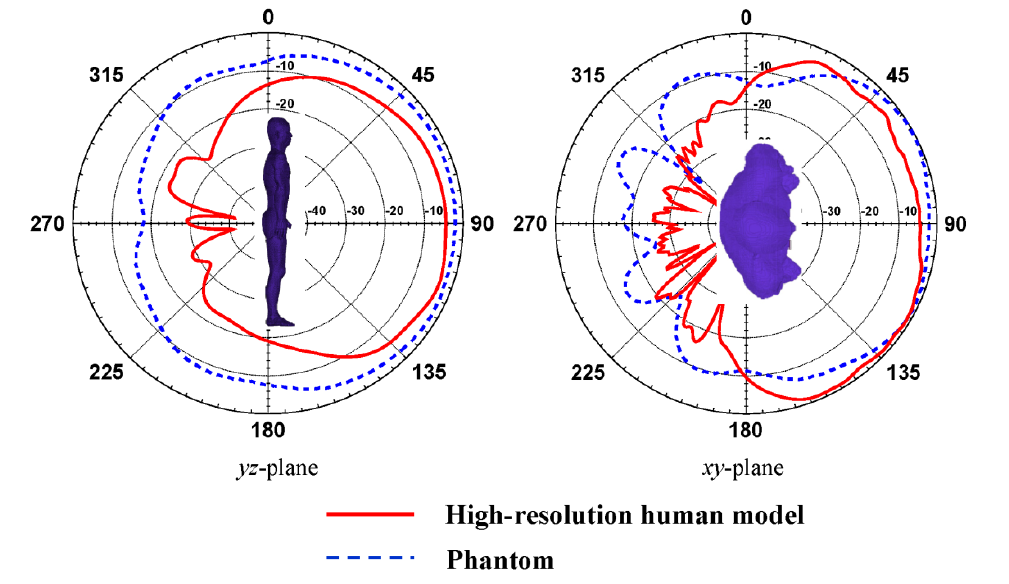
Figure 13. Simulated radiation patterns at 2.45